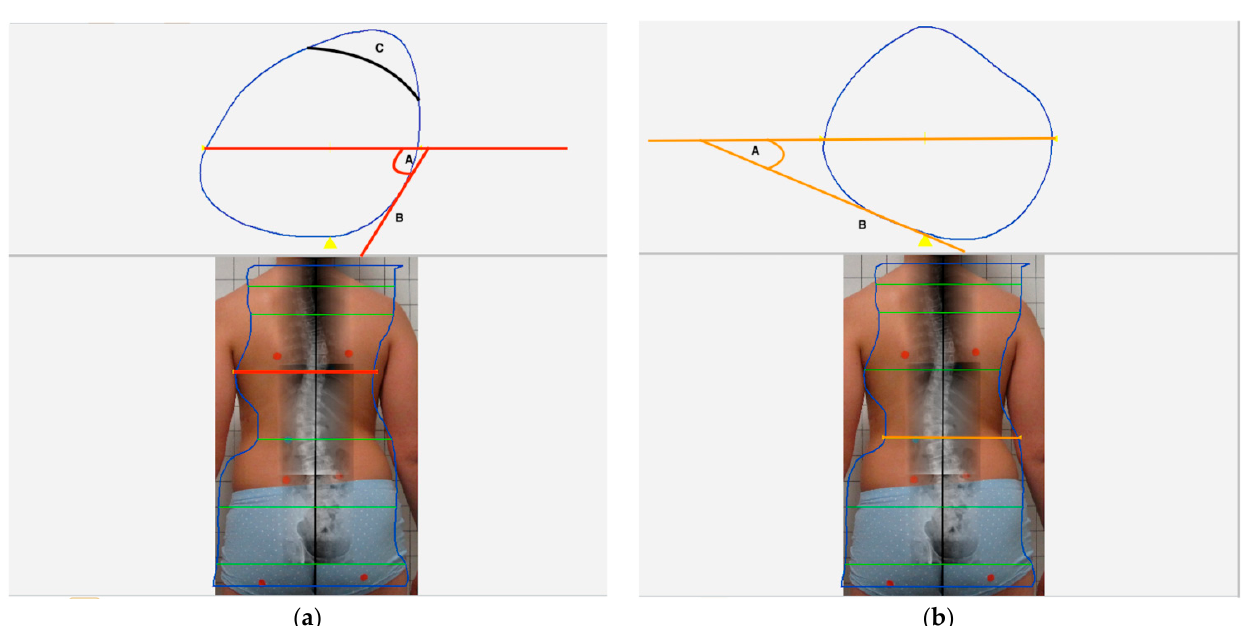
Figure 3. The figure shows the measurement technique of the lumbar (LPA) and the thoracic pres- sure point angles (TPA) as well as the position of the thoracic space. ( a ) The lower part of this image shows the level of the measurement plane (orange) at the lumbar apex. The a.p. X-ray image was transposed to the posterior photographic view of the patient and the planned 3-dimensional com- puter-aided-design – computer-aided-manufacturing (CAD-CAM) model of the brace was super- posed before. The upper part illustrates the cross-sectional area of the brace model at this orange level. A tangent was drawn to the lumbar pressure point ‘B’ and the angle between this tangent and the transversal body axis ‘A’ was measured = LPA. ( b ) The lower part of this image shows the level of the measurement plane (orange) at the thoracic apex. The upper part illustrates the cross-sectional area of the brace model at this orange level. A tangent was drawn to the thoracic pressure point ‘B’ and the angle between this tangent and the transversal body axis ‘A’ was measured = TPA. ‘C’ shows the usual position of the thoracic space (TS).